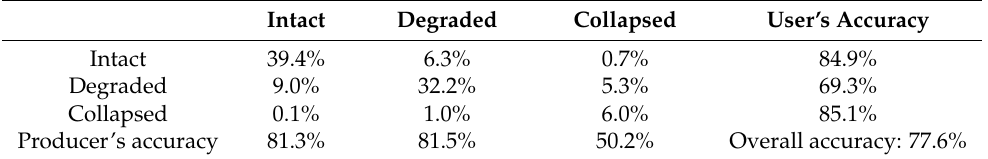
Table 5. Error matrix of the Rakhine mangroves degradation model. Cell entries represent percent of total area. Map categories are in rows while the reference categories are in columns. Intact Degraded User’s Accuracy Intact